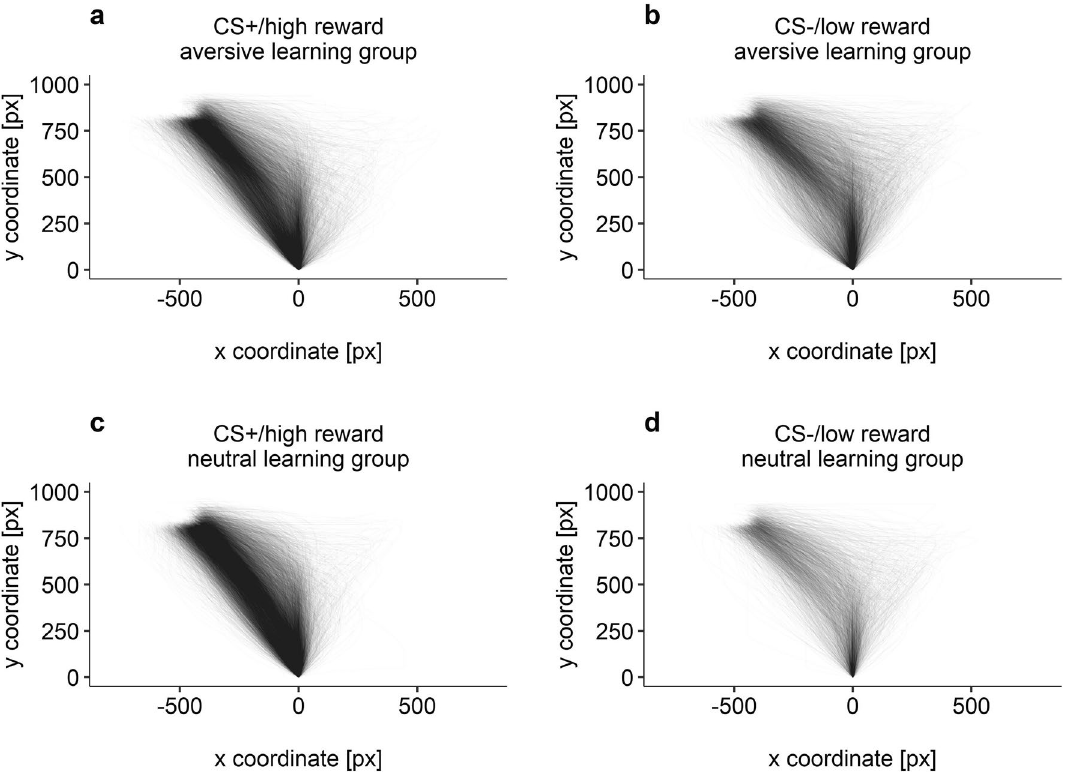
Figure 3. Individual movement trajectories for CS+/high reward choices in the aversive learning group ( a ), CS−/low reward choices in the aversive learning group ( b ), CS+/high reward choices in the neutral learning group ( c ), and CS−/low reward choices in the neutral learning group ( d ). All trajectories were flipped to the left, aligned to a common starting position and